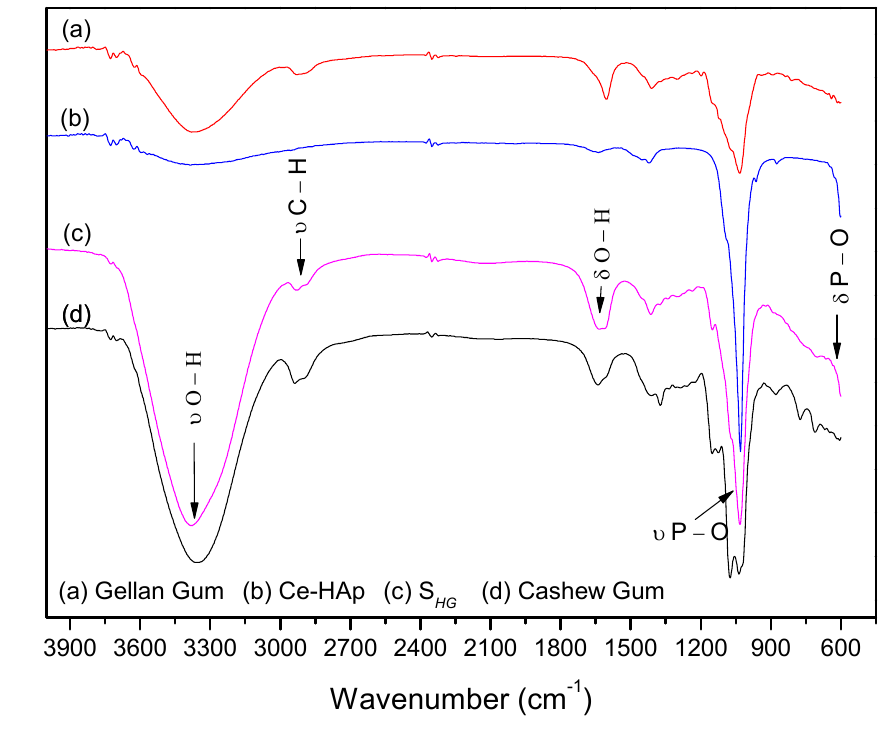
Figure 6. FTIR spectra of scaffold and precursor materials: (a) Gellan gum, (b) Ce-Hap, (c) S HG , and (d) cashew gum.